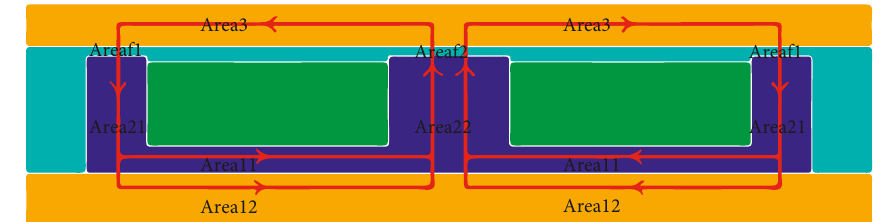
Figure 4: Distribution of magnetic circuits and areas.